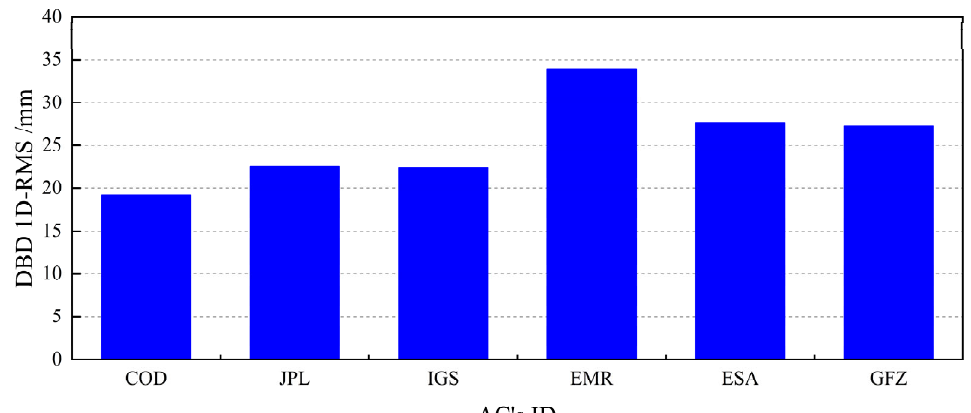
Figure 3. 1D ‐ RMS for DBD of each AC’s orbit product. Figure 3. 1D-RMS for DBD of each AC’s orbit